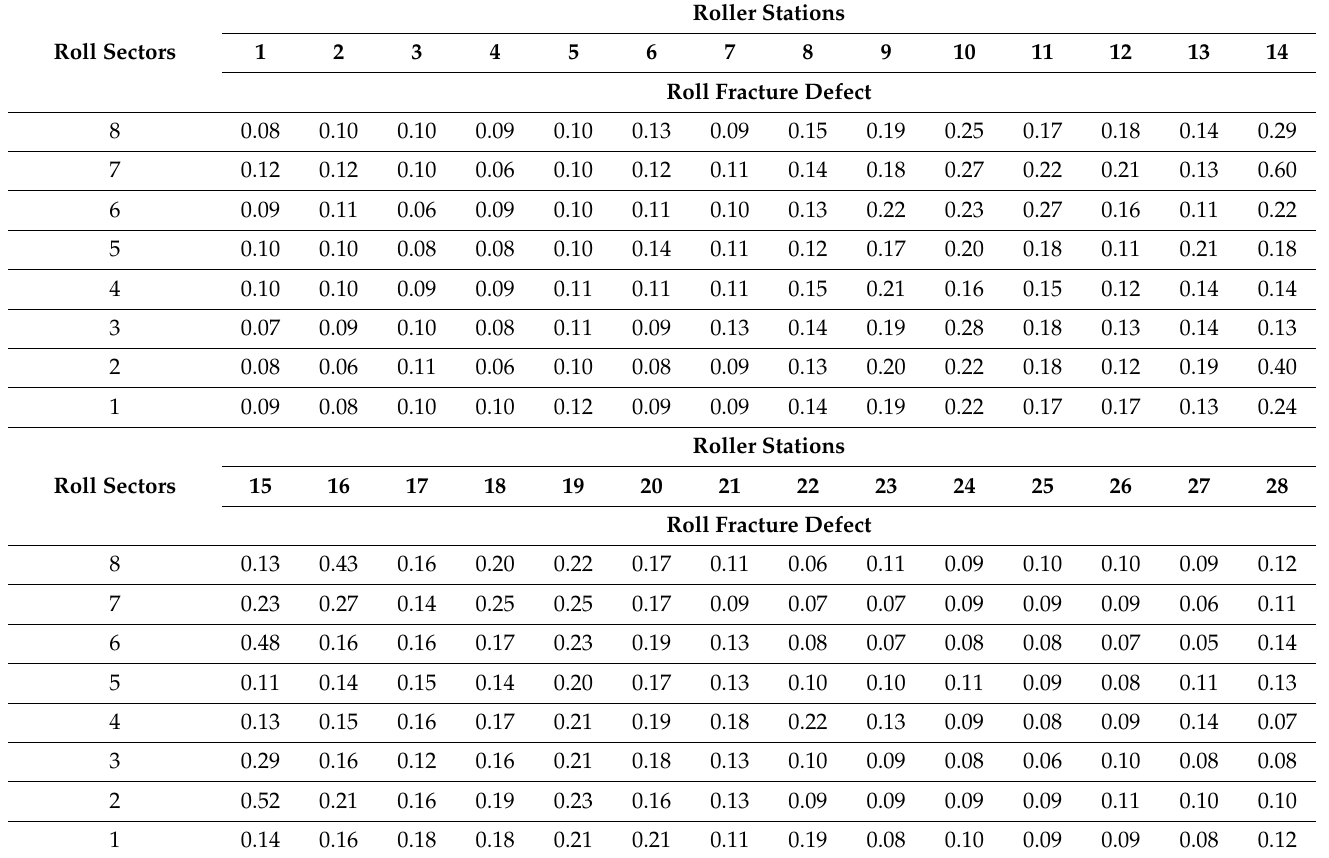
Table 5. Map of faults in the high chromium Hi-Cr cast roll, mm.